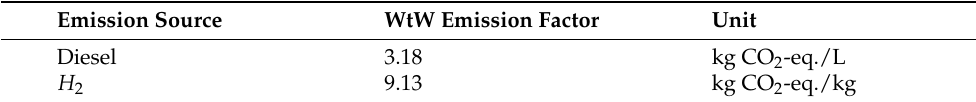
Figure 16. Simulation results for the sprayer work cycle. Table 5. WtW equivalent CO 2 emission factors for Diesel and H 2 .